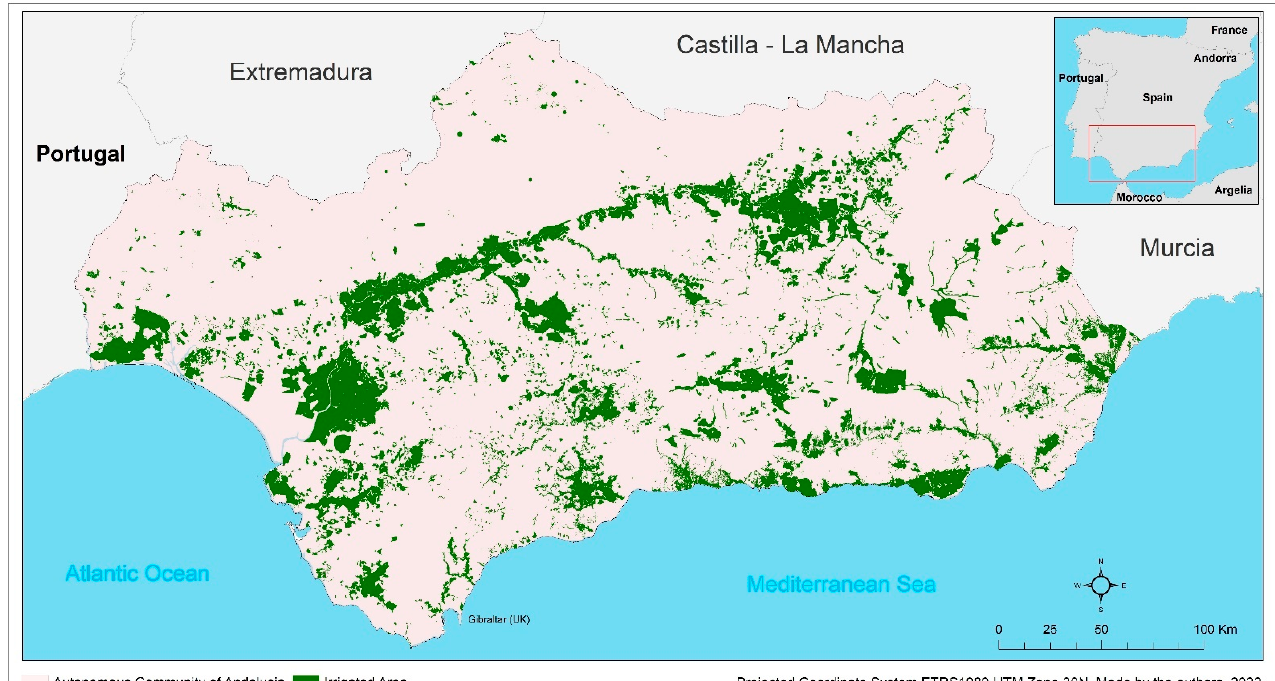
Figure 1. Current irrigated area in Andalusia . (Source: [22]).